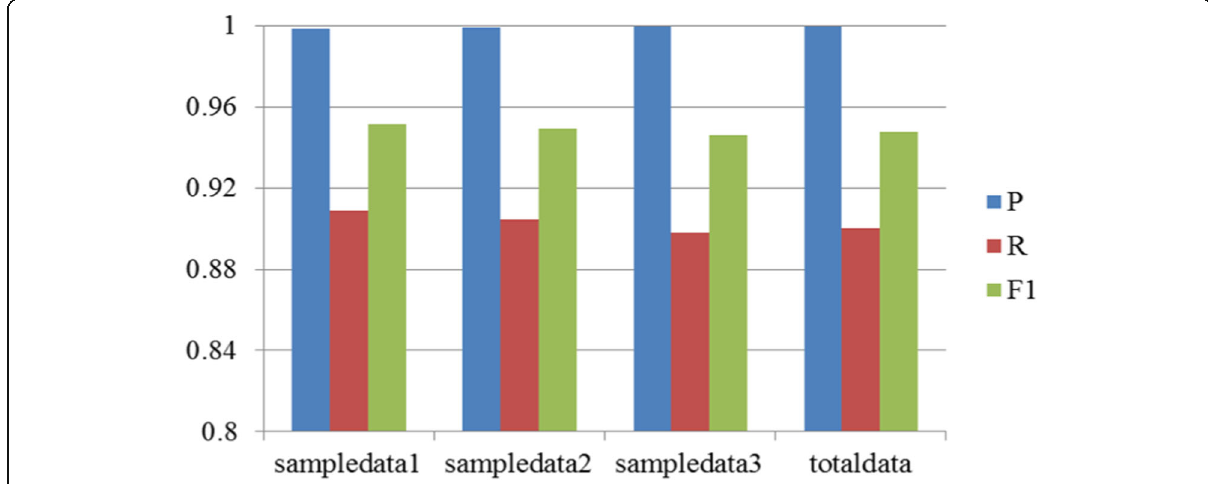
Fig. 8 Comparison of P, R, F1-score of LogOHC on multi-source log data